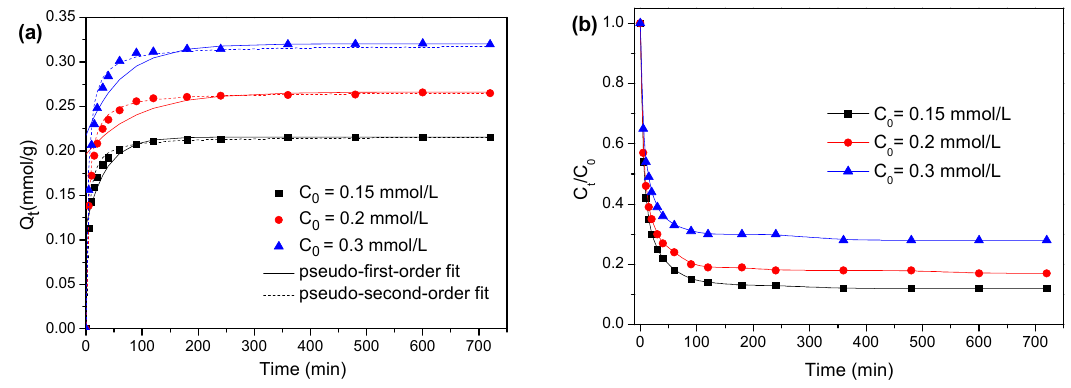
Figure 3. Adsorption kinetics ( a ) and C t /C 0 versus time ( b ) of CAP on AC (dosage = 30 mg/50 mL, temperature = 25 °C, pH = 6.20 ± 0.2).